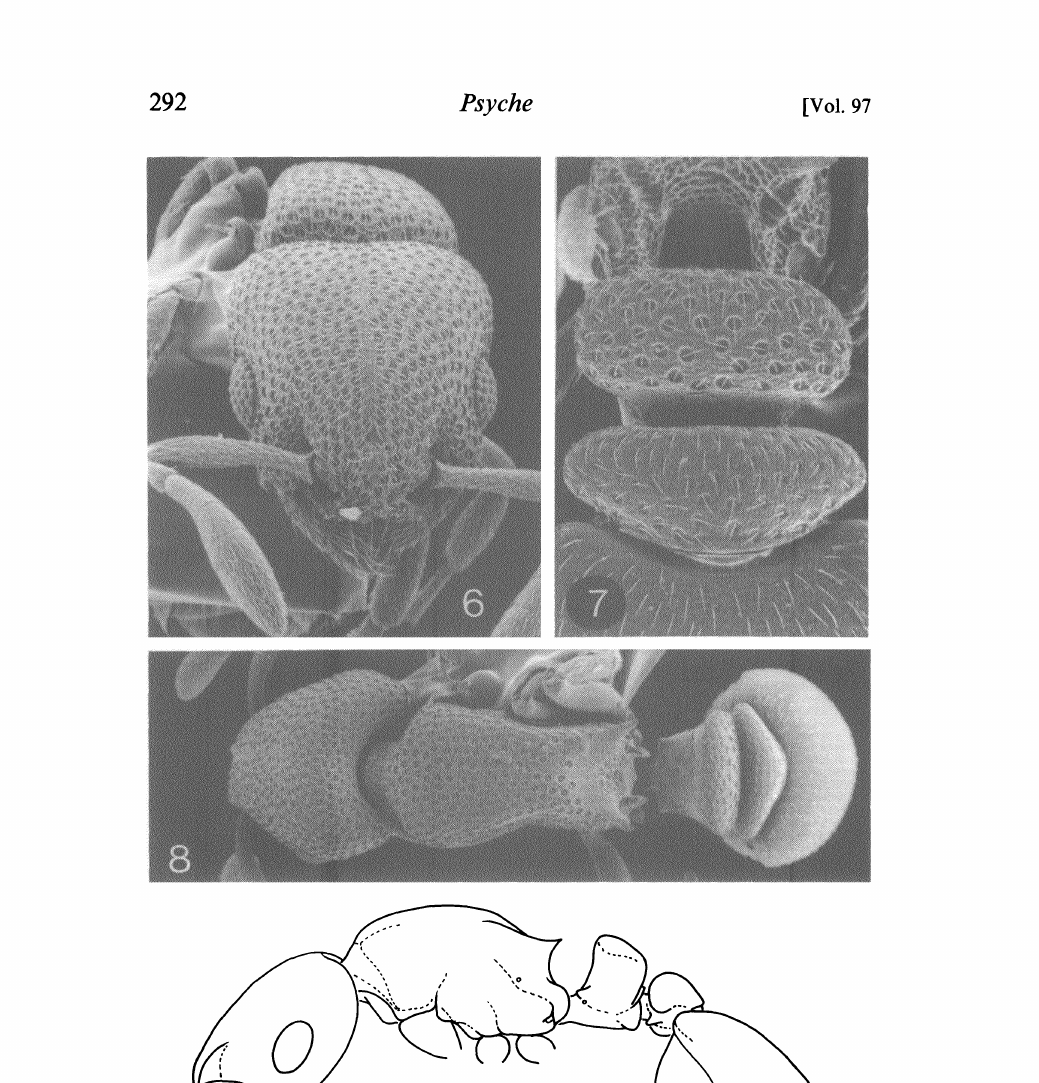
Figs 6-9: Willowsieila anderseni Taylor, 6. head, frontal; 7. petiole and postpeti- ole, dorsal; 8. whole animal, dorsal; 9. whole animal, lateral; see text for